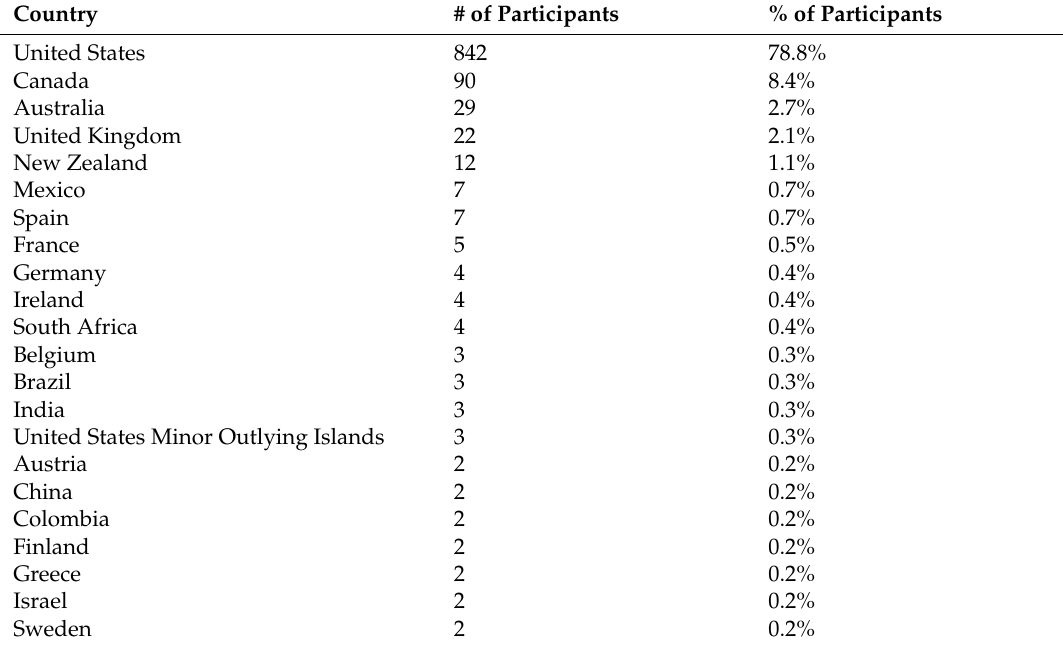
Table 3. Distribution of participants within the Global PWS Registry by